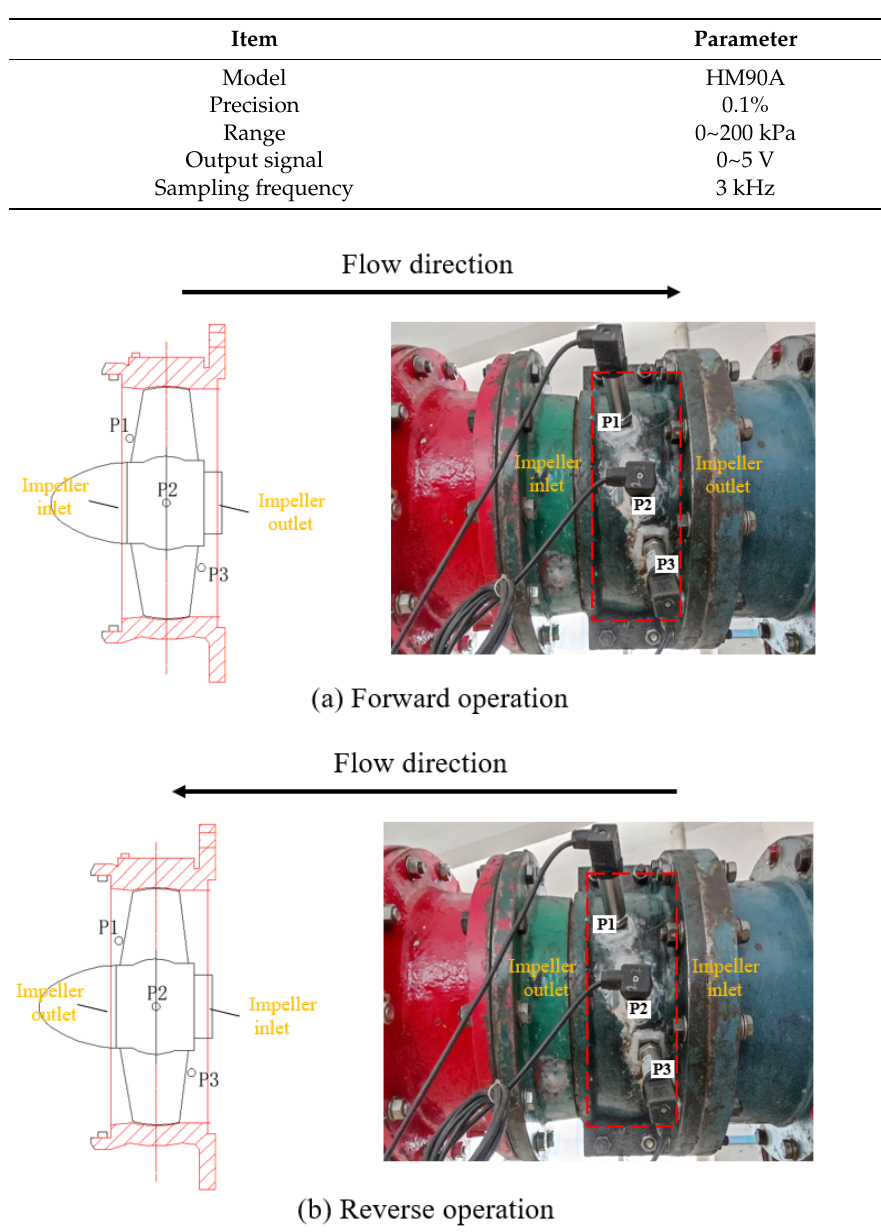
Figure 6. Schematic layout of pressure pulsation measuring